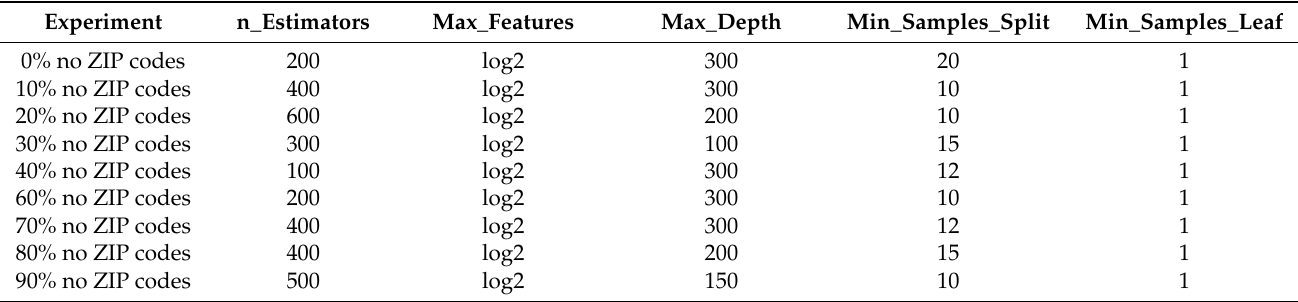
Table A3. Optimal hyperparameters for the RF.